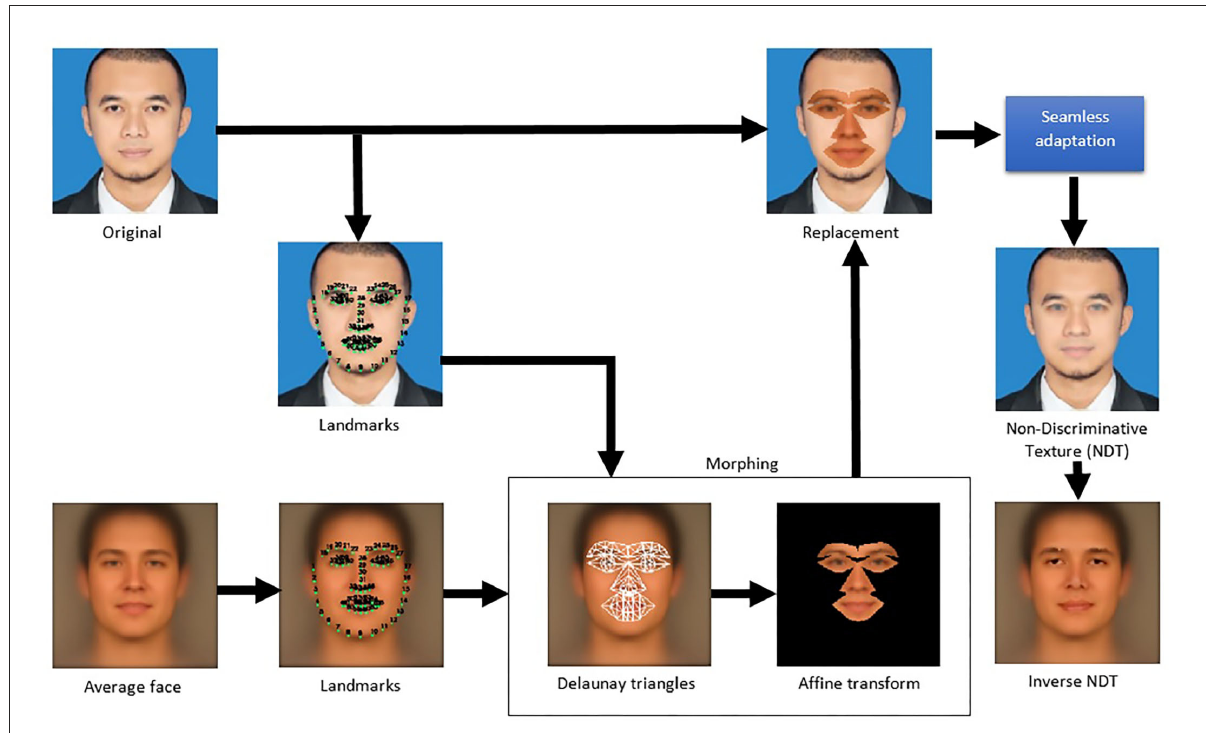
FIGURE2 The non-discriminative texture (NDT) neutralized the discriminative information inside the face components without changing the